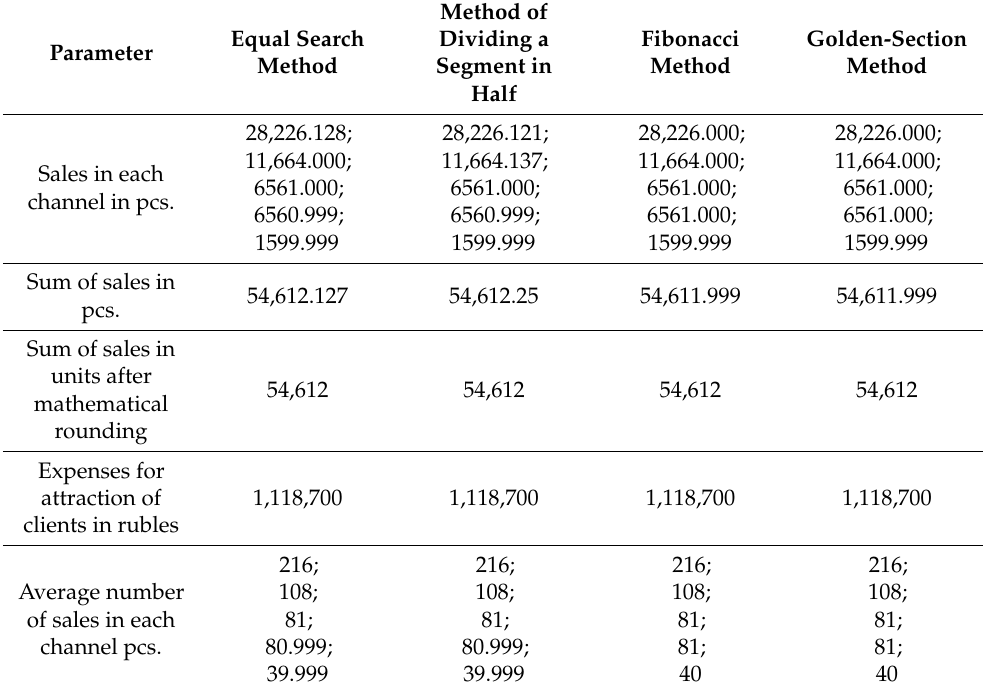
Table 12. Results of the search for the solution of the target function by methods from the group of direct methods for the year